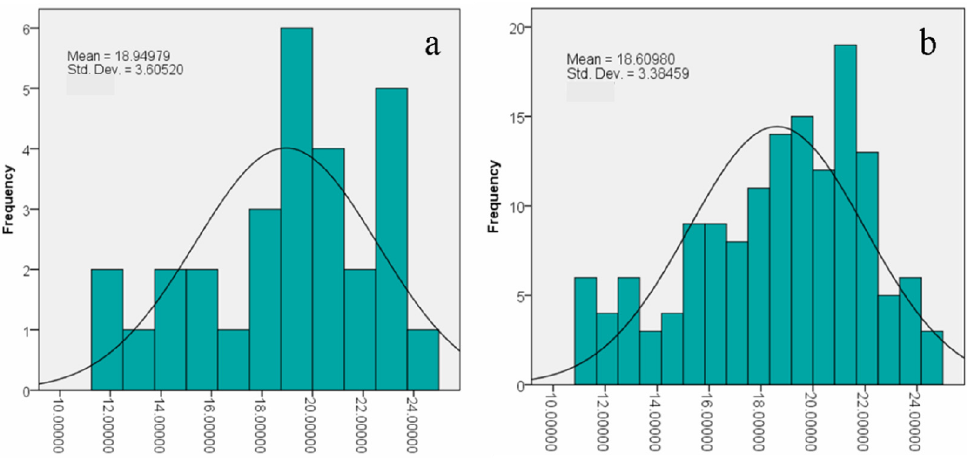
Figure 14. Frequency of sediment angle: ( a ) histogram based on physical test ( n = 29); ( b ) histogram based on random field ( n = 147).